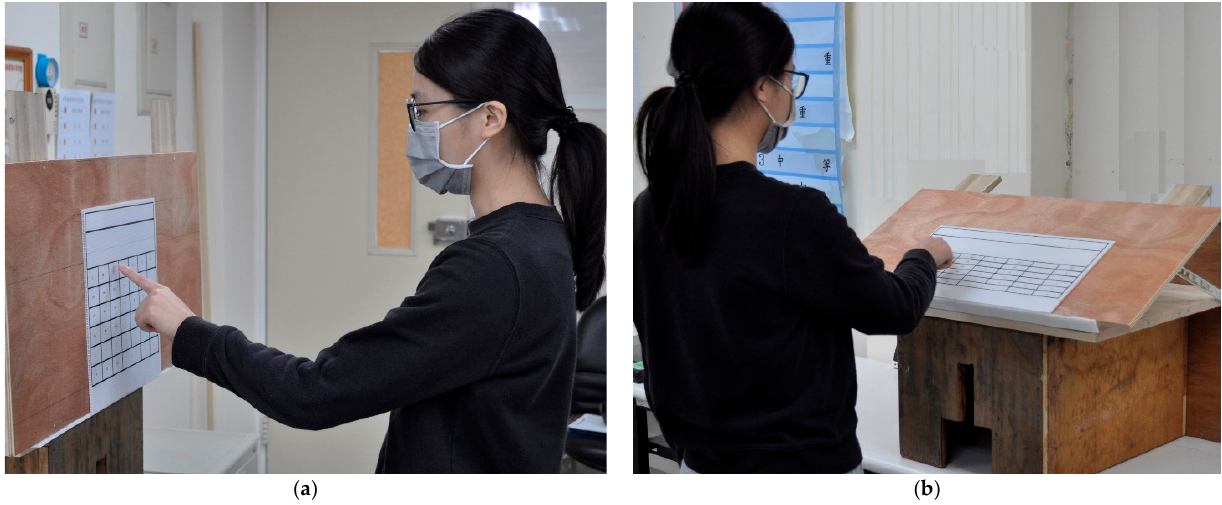
Figure 2. Calculator panel drawn on a plastic board for the physical pointing tasks: ( a ) 90 ° , ( b ) 30